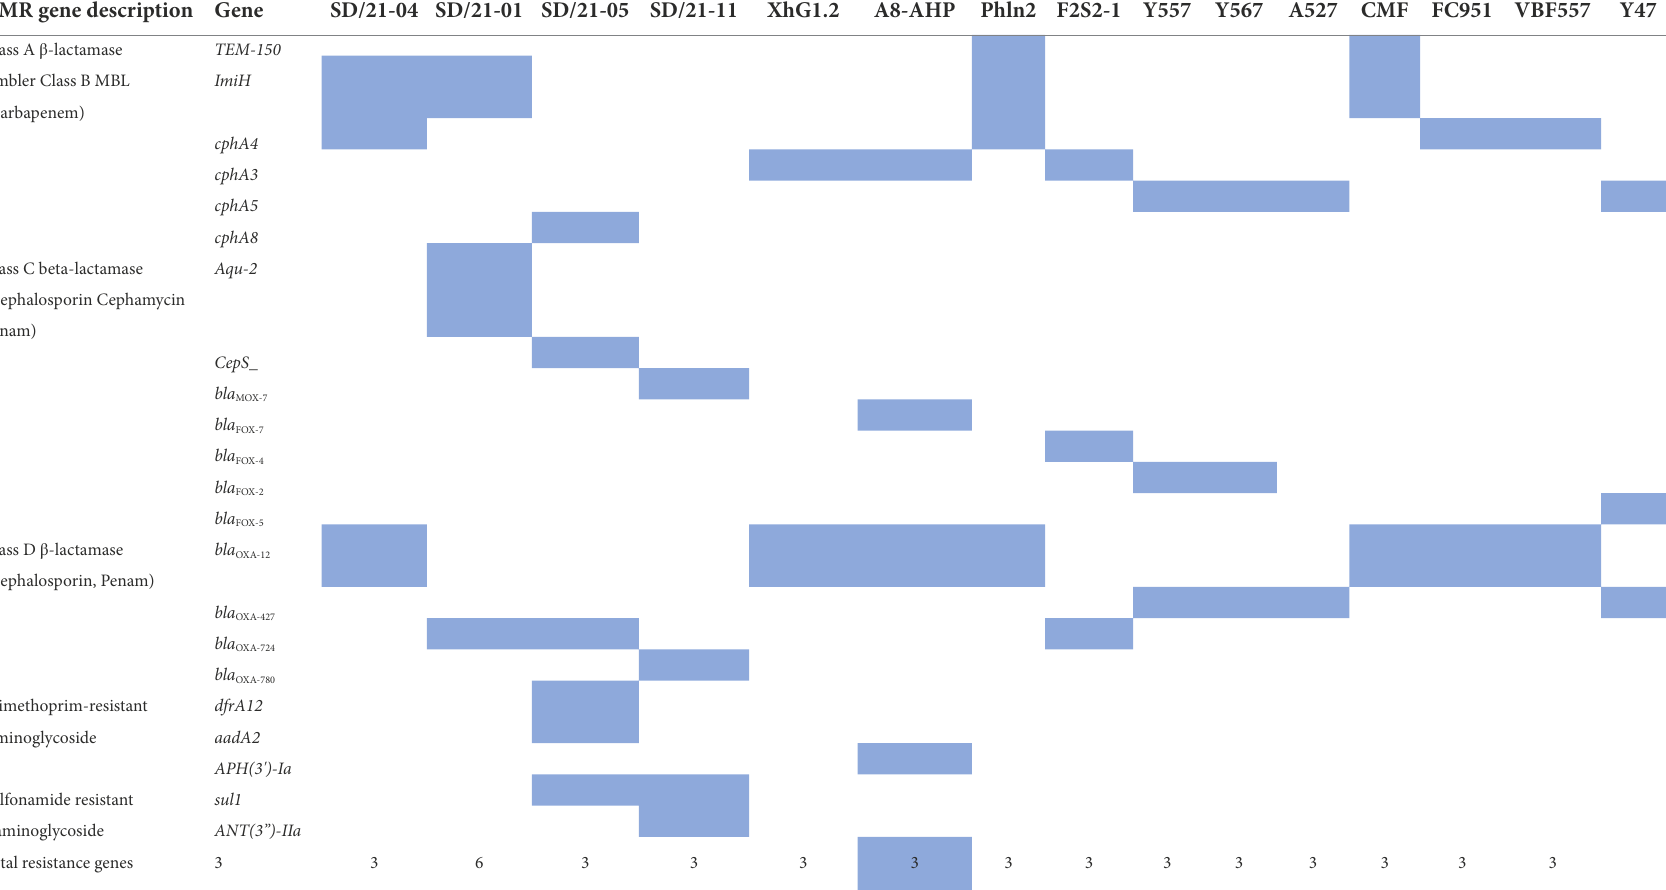
TABLE 4 Antimicrobial resistance genes detected in the Aeromonas